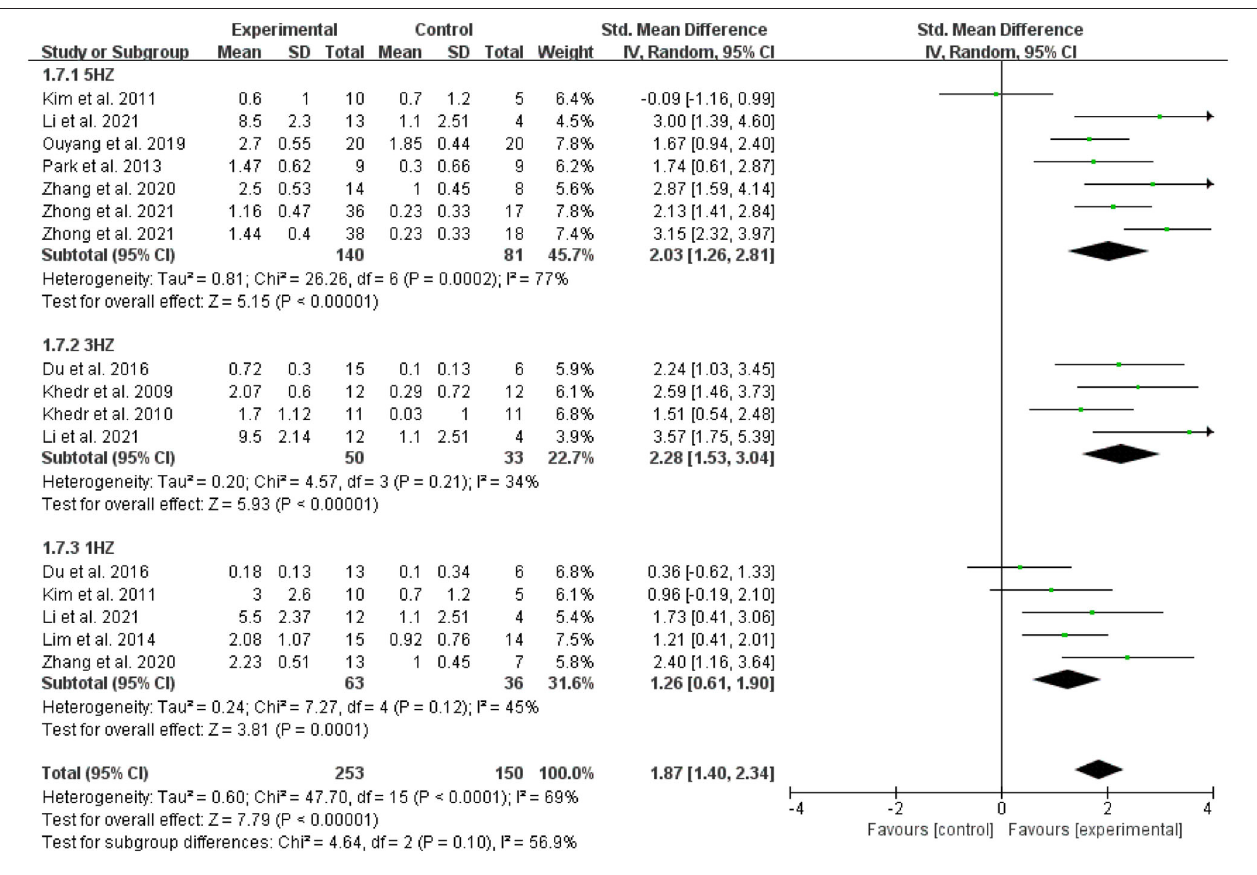
FIGURE 7 | Comparison of the effect size of 5, 3, and